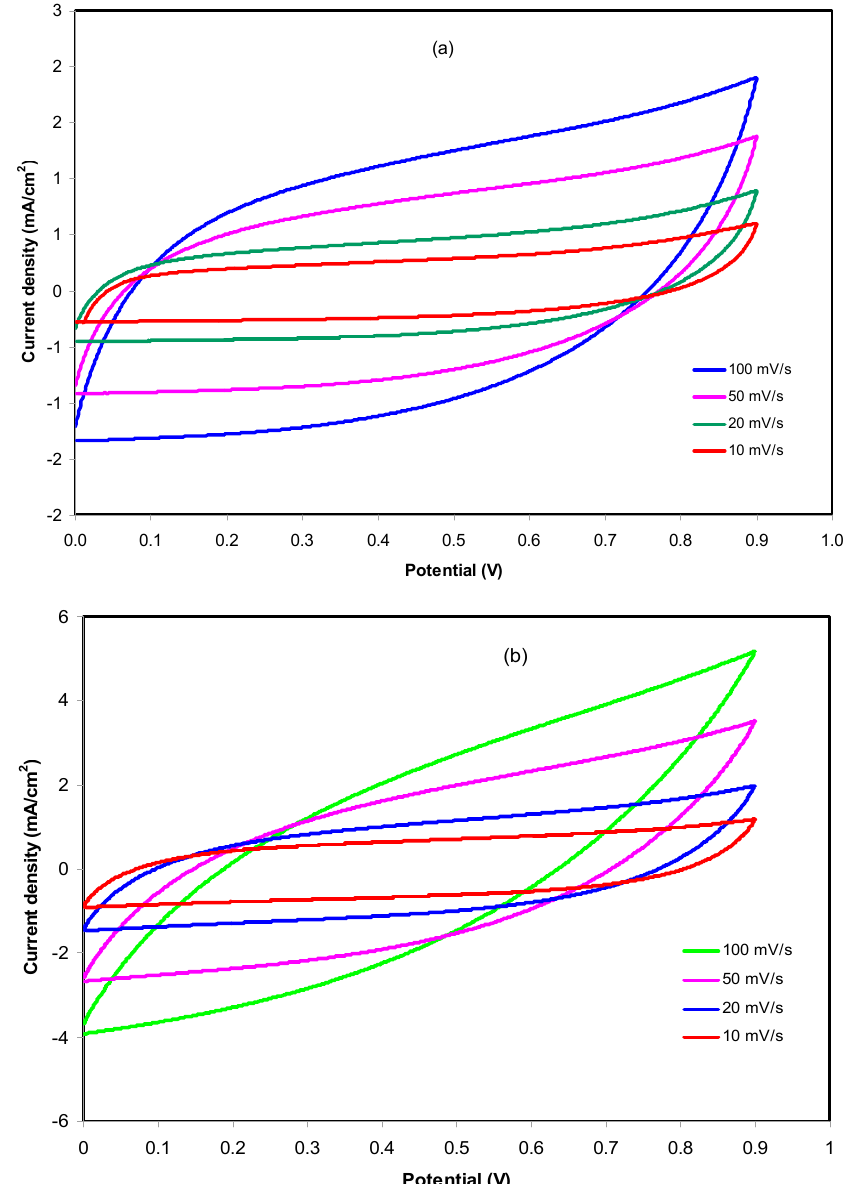
Figure 5. CV curves of the fabricated EDLC using ( a ) CSNHG4 and ( b ) CSNHG5 electrolyte at different scan rates.